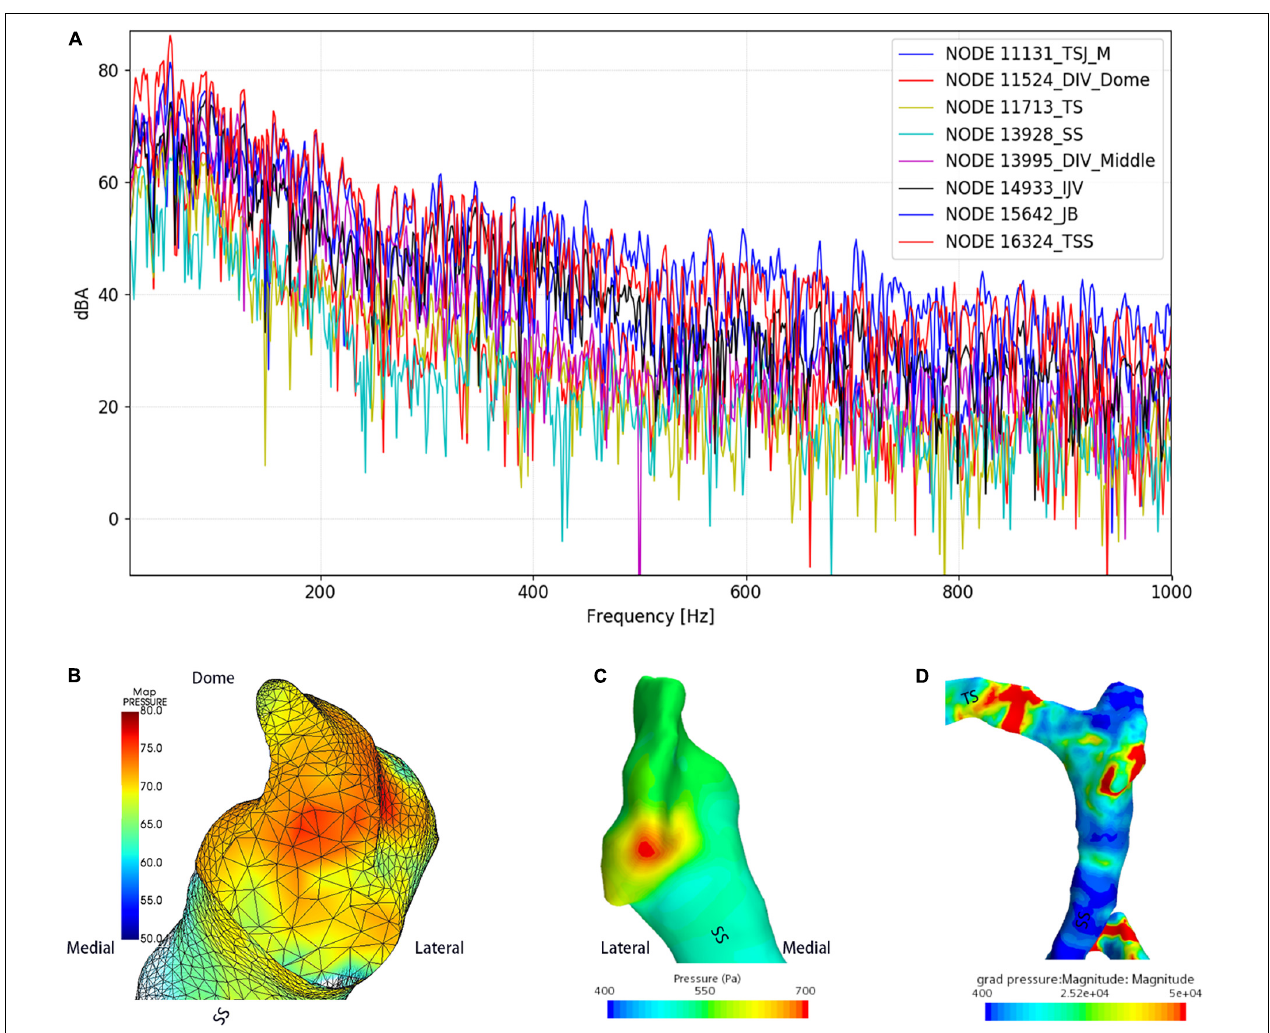
FIGURE 7 | Regional hydroacoustic characteristics of the ipsilateral transverse–sigmoid sinus. SS indicates the sigmoid sinus. (A) The amplitude–frequency spectrum of the ipsilateral transverse–sigmoid sinus. (B) The amplitude of the diverticular flow (unit: dBA). (C) Wall pressure distribution at the transverse–sigmoid junction and the diverticulum. (D) Pressure gradient distribution of the ipsilateral transverse–sigmoid sinus.